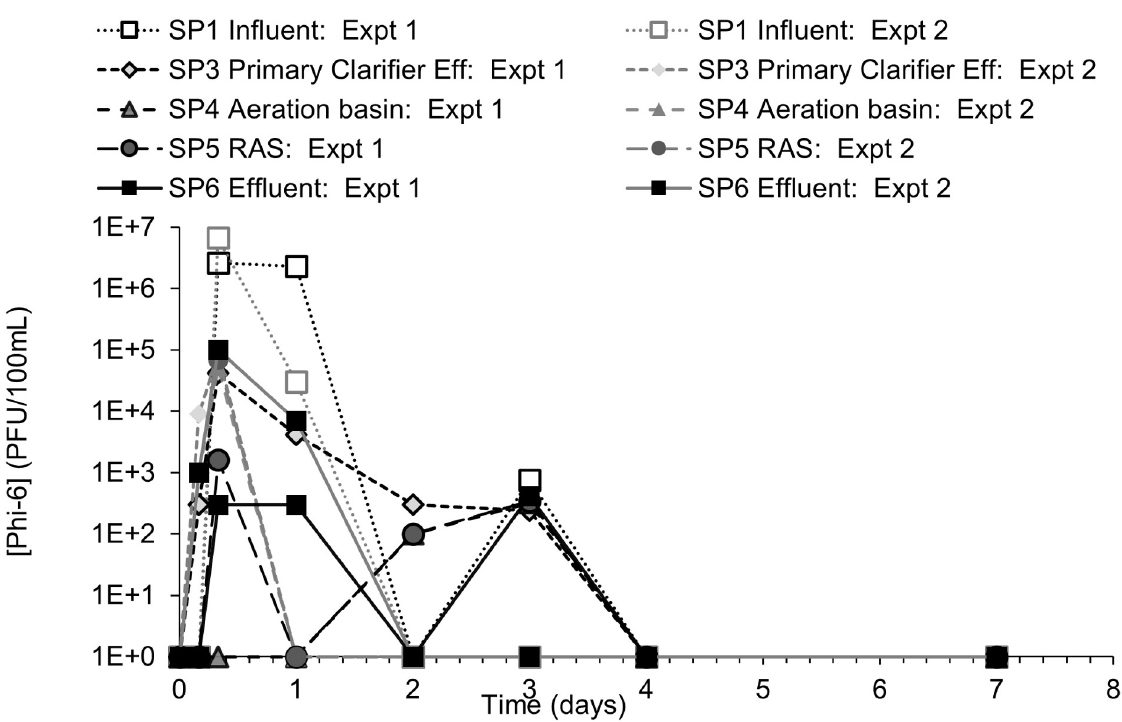
Fig 7. Phi-6 concentration response curves for Tests 1 and 2. Concentration-time plot of individual sample ports over time for experiment 1 and experiment 2.